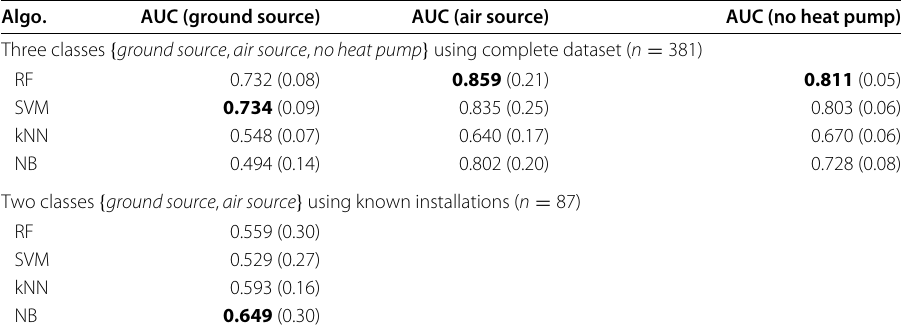
Table 4 Heat pump type (reservoir) with data from week 10, 2020 using smart meter and weather features Algo. AUC (ground